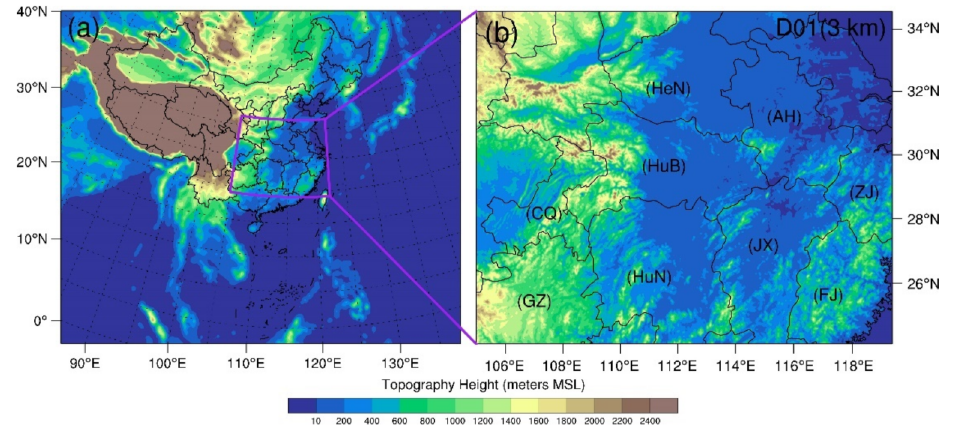
Figure 1. The little global map ( a ) and configuration of the WRF model domain with a grid spacing of 3 km ( b ). The colors represent model terrain heights. The abbreviations for the Henan, Anhui, Hubei, Chongqing, Guizhou, Hunan, Jiangxi, Zhejiang, and Fujian Provinces are HeN, AH, HuB, CQ, GZ, HuN, JX, ZJ, and FJ,